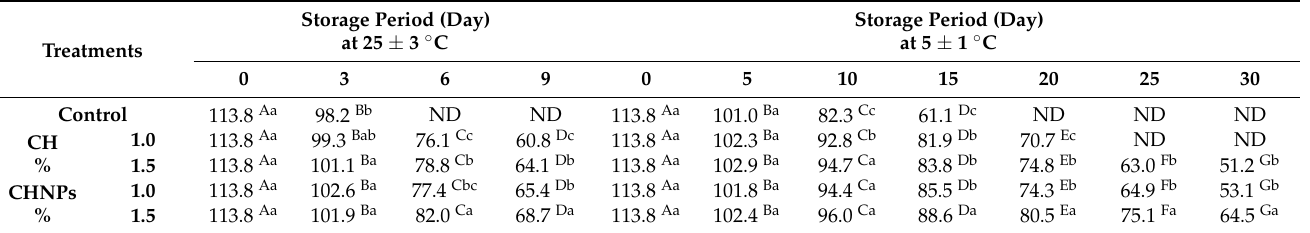
Storage Period (Day) at 5 ± 1 ◦